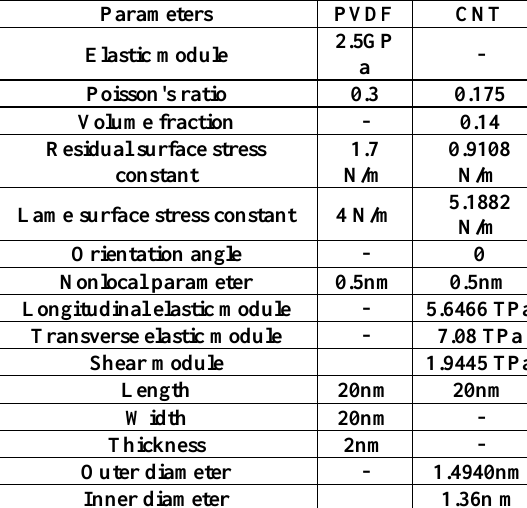
Table 5. Material properties, surface properties and geometry dimensions of square nano-plate reinforced by CNT